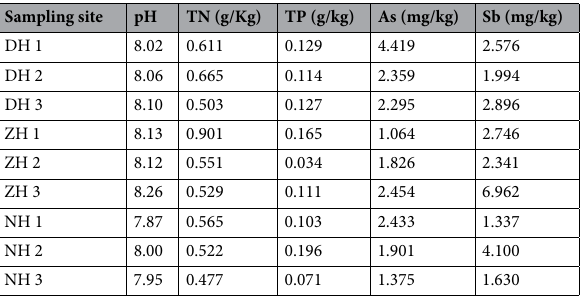
Table 1. Physical and chemical indexes of sediments in Huaibei collapsed lakes.